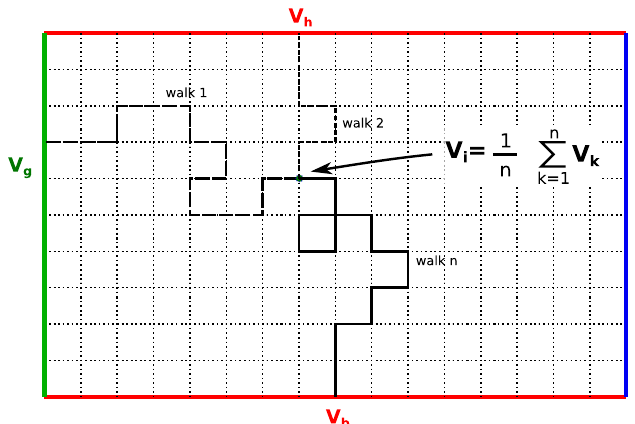
Fig. 9. Example of a potential computation using random walk in 2